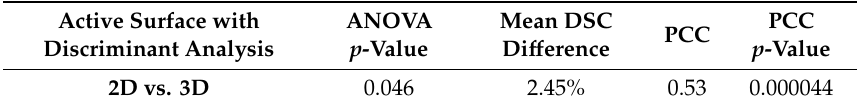
Table 2. ANOVA and PCC on the DSC showed statistical di ff erences between 2D and 3D segmentation